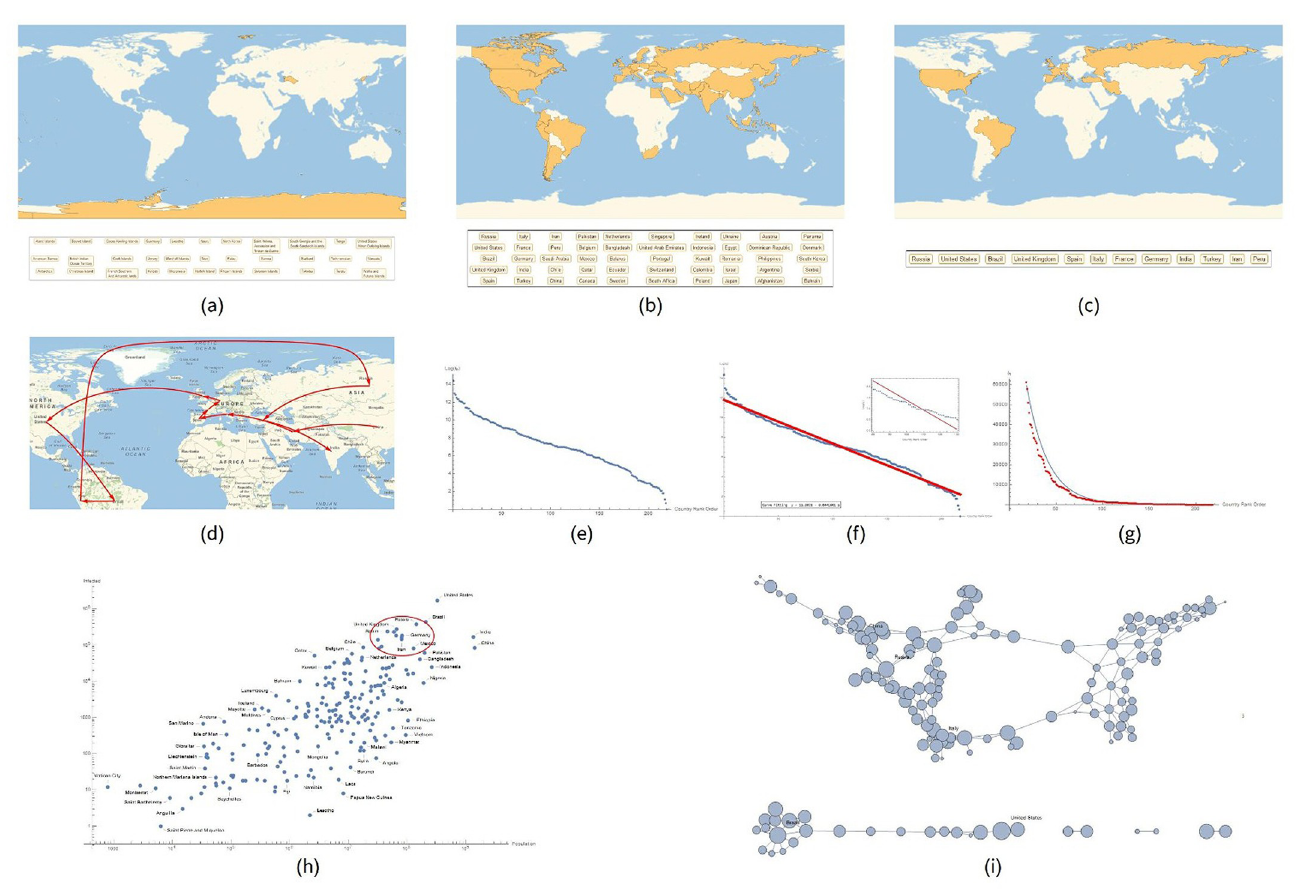
Fig 1. Geo-spatial transmission of the SARS-CoV-2. In this figure, (a), (b) and (c) represent the Countries of the world with almost no infected, 10,000 and 100,000 number of infected respectively. (d) Presents the spatial ignition of each country, represented as red arrows. (e) Shows the exponential function fitted with real data. Some of the most infected countries are in the red circle. (f), (g) and (h) represent the total number of infected people per country, the Log plot on a logarithmic scale, and the population number for each country and the number of infected respectively. Finally, (i) shows a graph of the 217 countries with some of the most infected ones. In the graph, the nodes represent countries while the links connect geographically neighbouring countries. The data collection began on January 22, 2020 and ended on May 28, 2020.